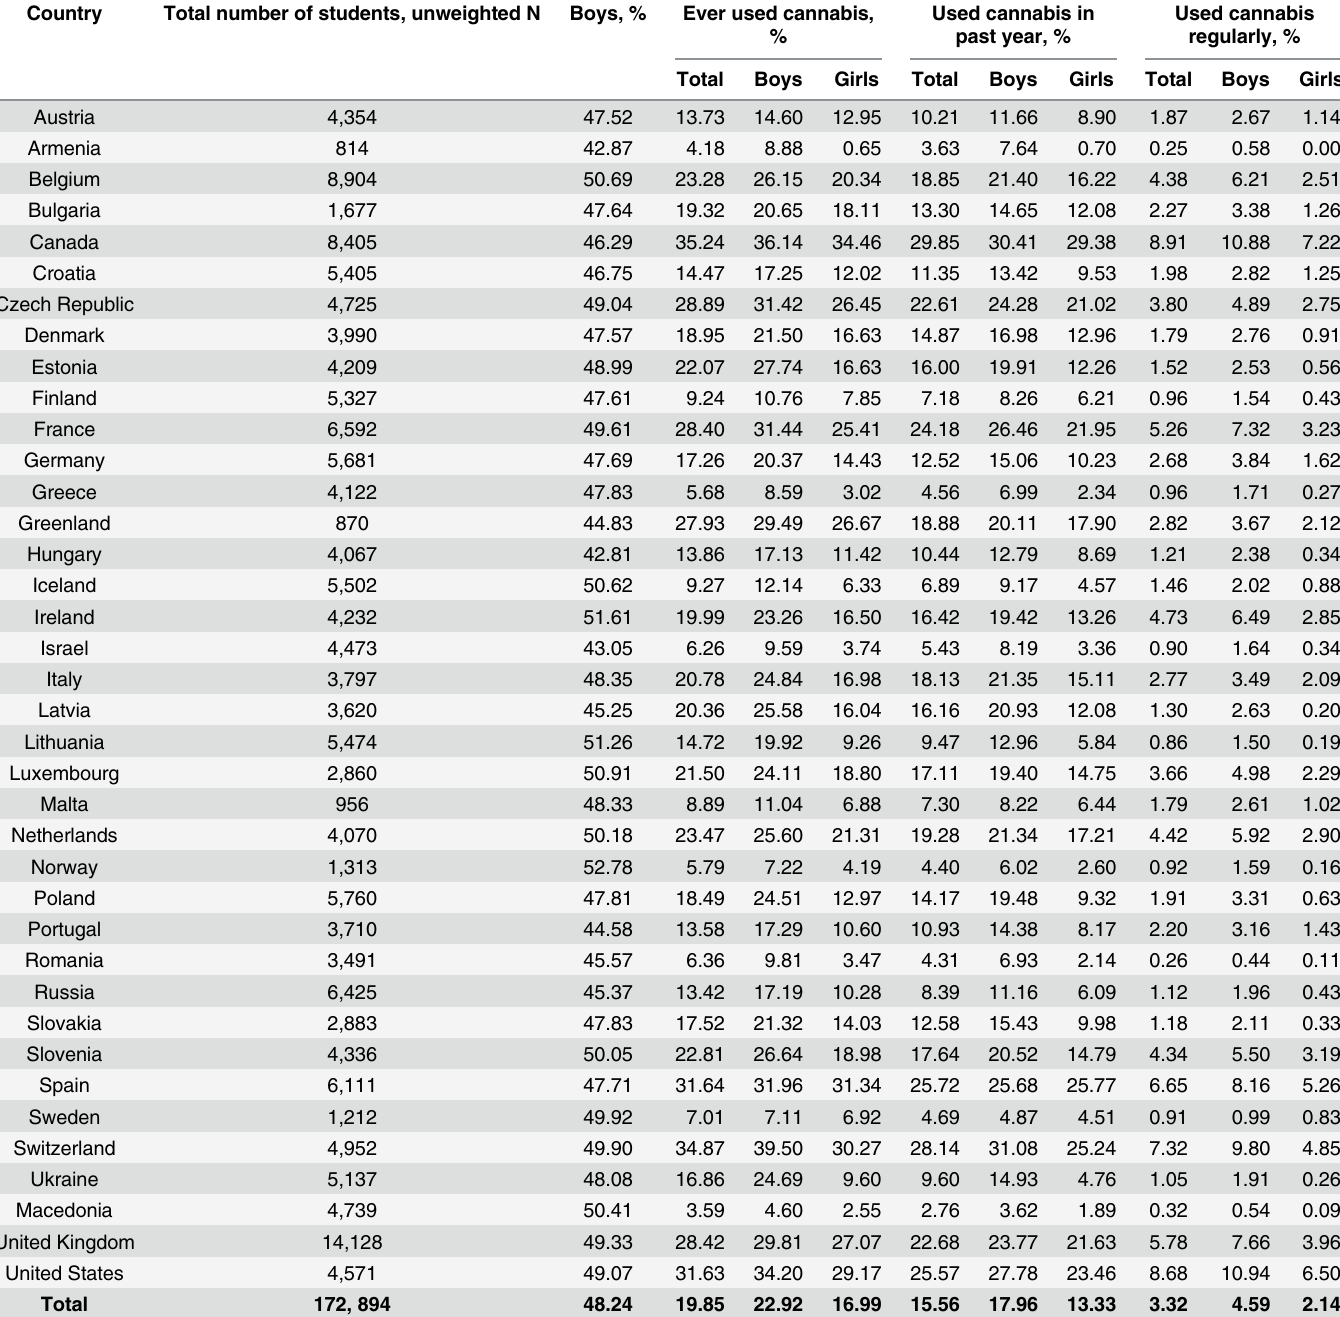
Table 1. Summary of cannabis use prevalence by country and gender, HBSC 2001 – 2010 (N = 172,894).